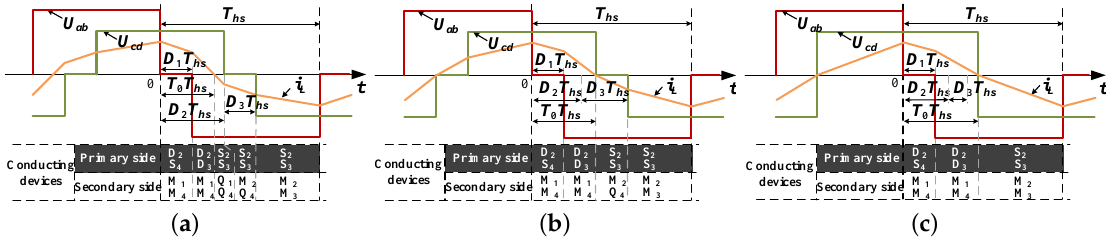
Figure 6. Waveforms of sub modes under M I : ( a ) M I1 ; ( b ) M I2 ; and ( c ) M I3 .